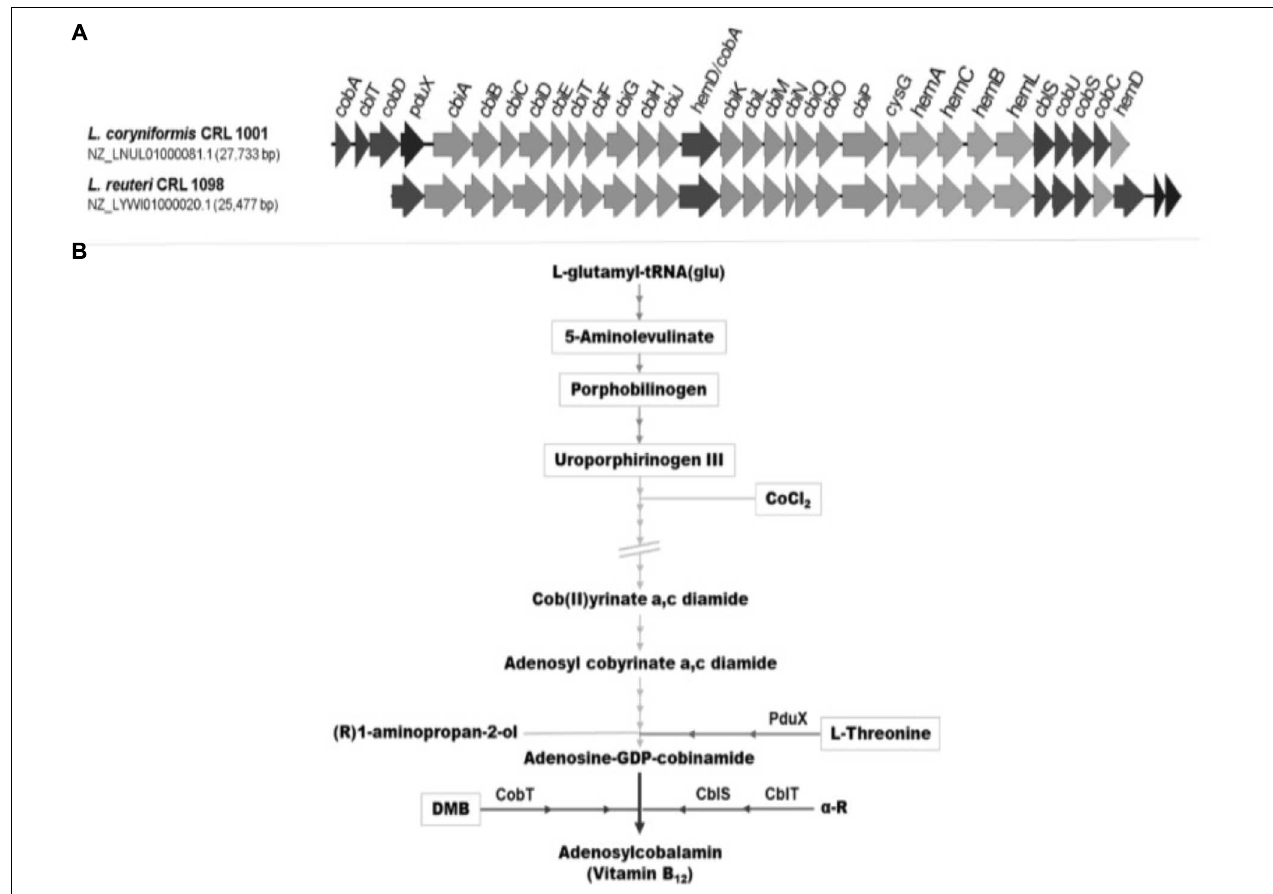
FIGURE 1 | (A) cbi - cob - hem gene clusters of L. coryniformis CRL 1001 and L. reuteri CRL 1098. (B) Simplified cobalamin anaerobic synthesis pathway. Addition of different pathway intermediaries are highlighted with a